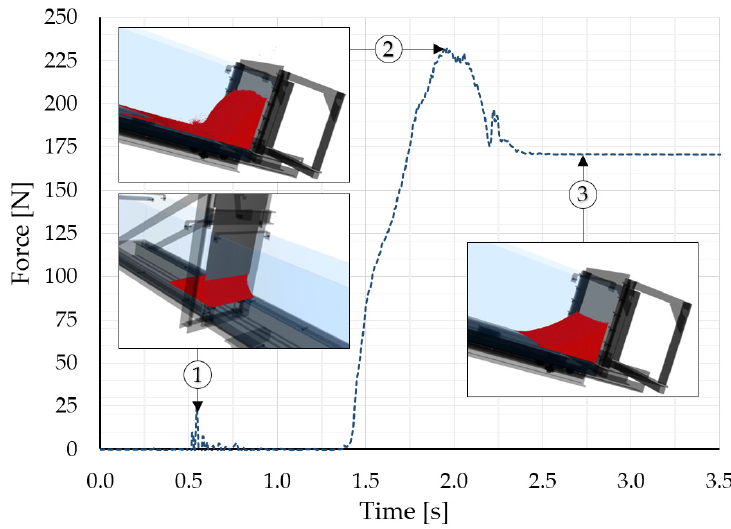
Figure 5. Example of a force–time history for phases 1 to 3 of the experimental procedure.